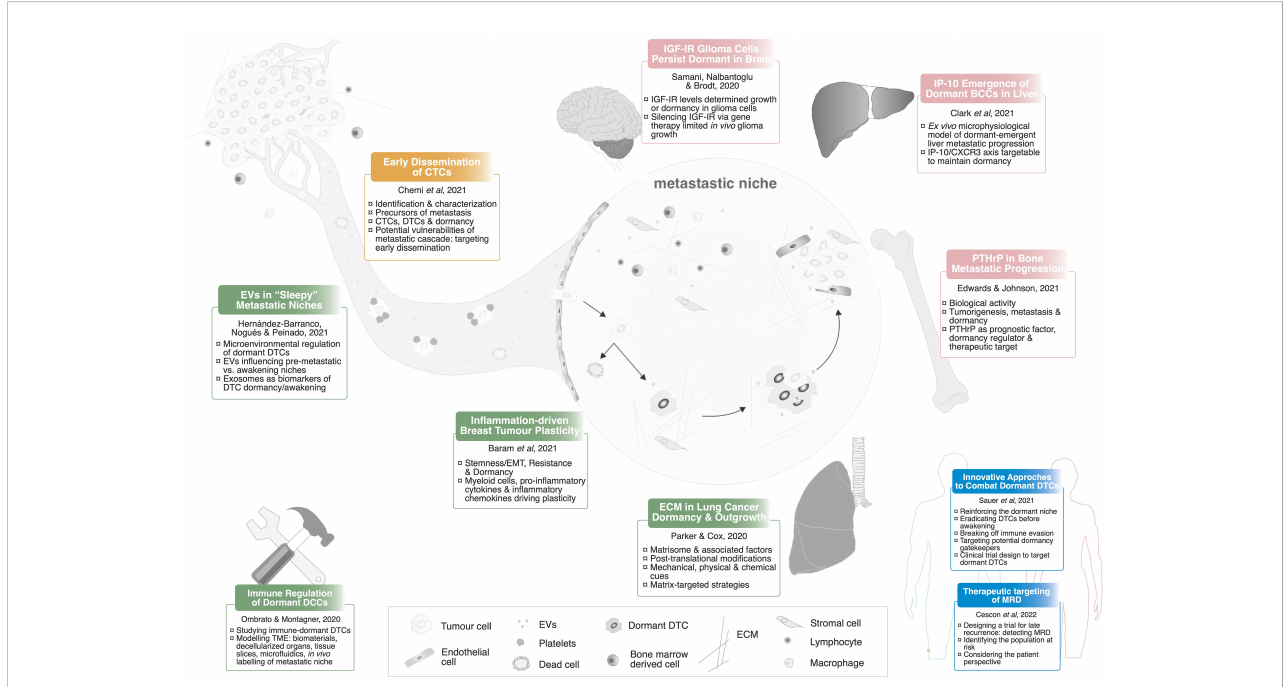
FIGURE 1 Revisiting the Seed and Soil hypothesis. All the articles included in the Research Topic are summarised in this schematic representation. CTCs, Circulating Tumour Cells; EVs, Extracellular Vesicles; DTCs, Disseminated Tumour Cells; EMT, Epithelial-to-Mesenchymal Transition; TME, Tumour Microenvironment; ECM, Extracellular Matrix; MRD, Minimal Residual